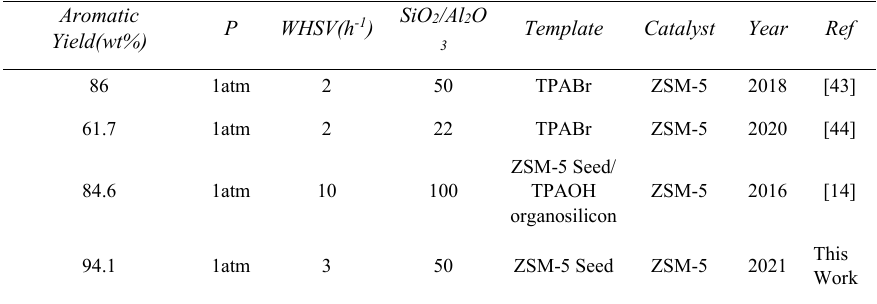
Table. 8. Comparison results with other literature in MTA Table 8. Comparison results with other literature in